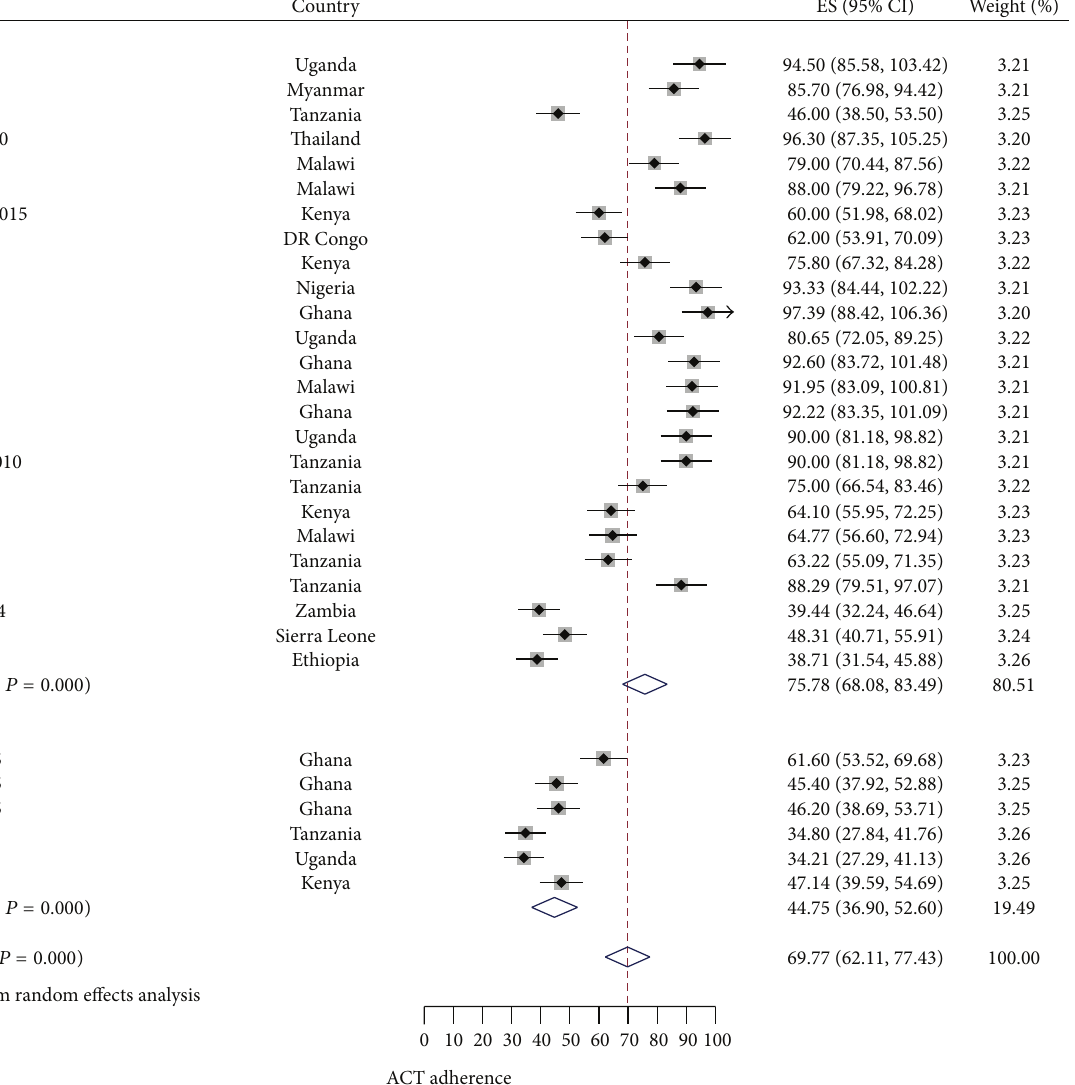
Figure 2: Forest plot of prevalence of adherence in the public and retail